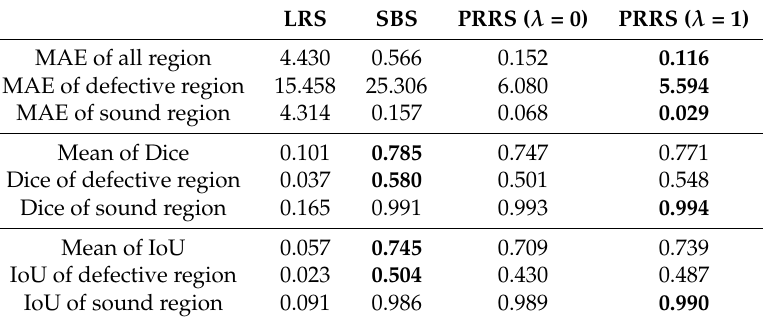
Figure 5. 3D plots of the input data and result. Table 3. Comparative results of the proposed method with other